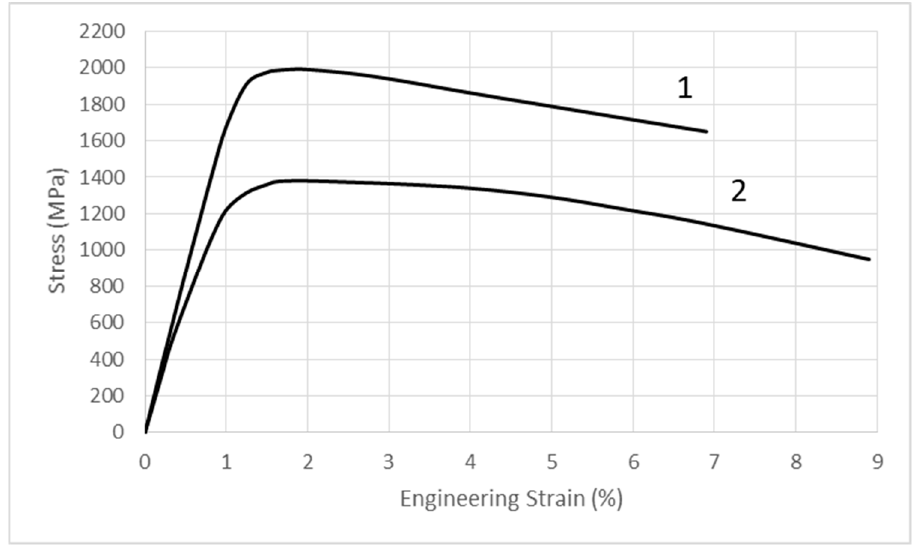
Figure 3. Typical stress ‐ strain curves of the tested steel: 1—25 °C; 2—500 °C.